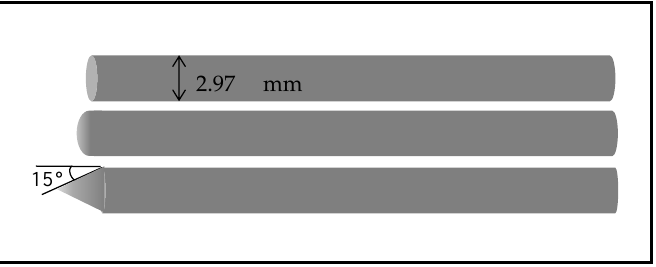
Figure 4. The supercavitation bodies.